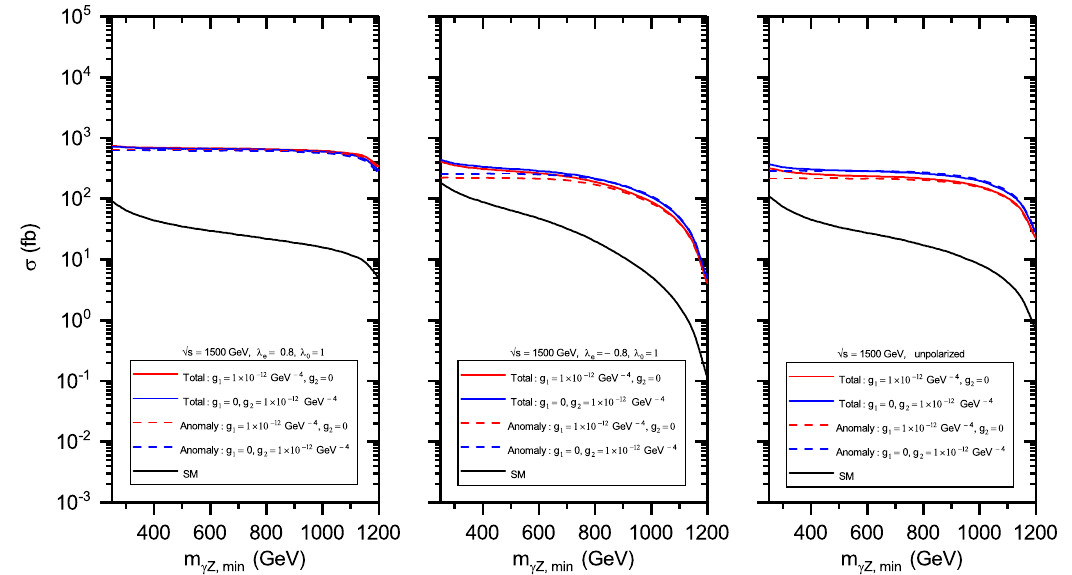
Figure 4 . The total cross sections for the process γγ → γZ as functions of the minimal invariant √ mass of the outgoing bosons for the e + e − collider energy s = 1500 GeV. The left, middle and right panels correspond to the electron beam helicities λ e = 0 . 8 , − 0 . 8 , and 0, respectively. On each plot the curves denote (from the top downwards) the total cross sections for the couplings g 1 = 10 − 12 GeV − 4 , g 2 = 0 , and g 1 = 0 , g 2 = 10 − 12 GeV − 4 , the anomalous contributions for the same values of couplings, the SM cross